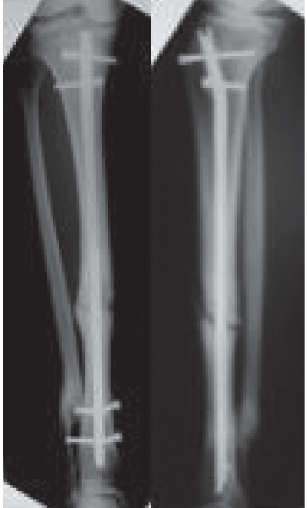
Table 5 - Comparison of deformities immediately postsurgery vs at the 1-year follow-up